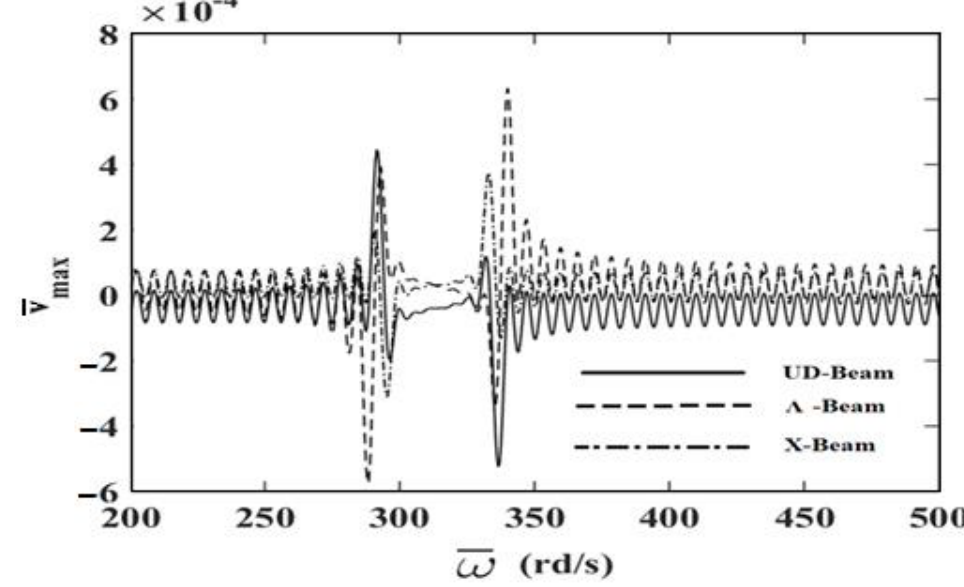
Figure 5. The relationship between the displacements and the frequency of the dynamic load ( 𝑤̅ ) for V CNT = 0.12.